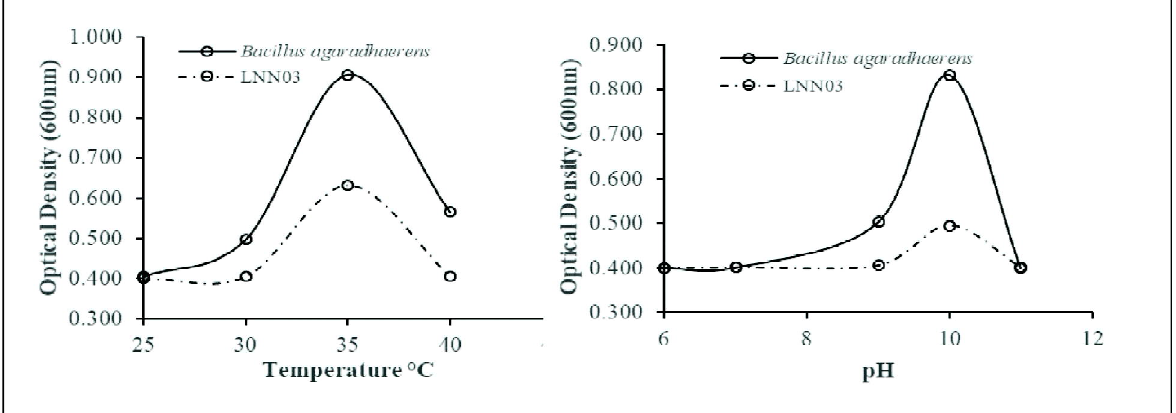
Figure 1: Growth of Bacillus agaradhaerens (LNC06) and LNN03 against temperature and